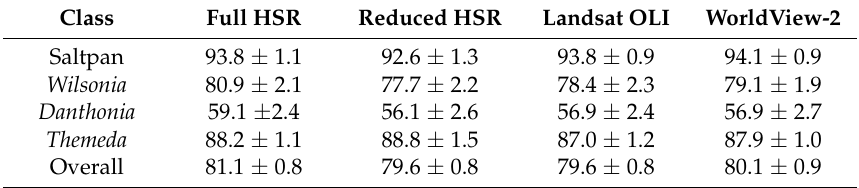
Table 3. Average RF training accuracy and standard deviations for all four-class results, as averaged across the 30 RF models. Accuracies are presented as mean percentages, while standard deviation is presented as a percentage range above or below the